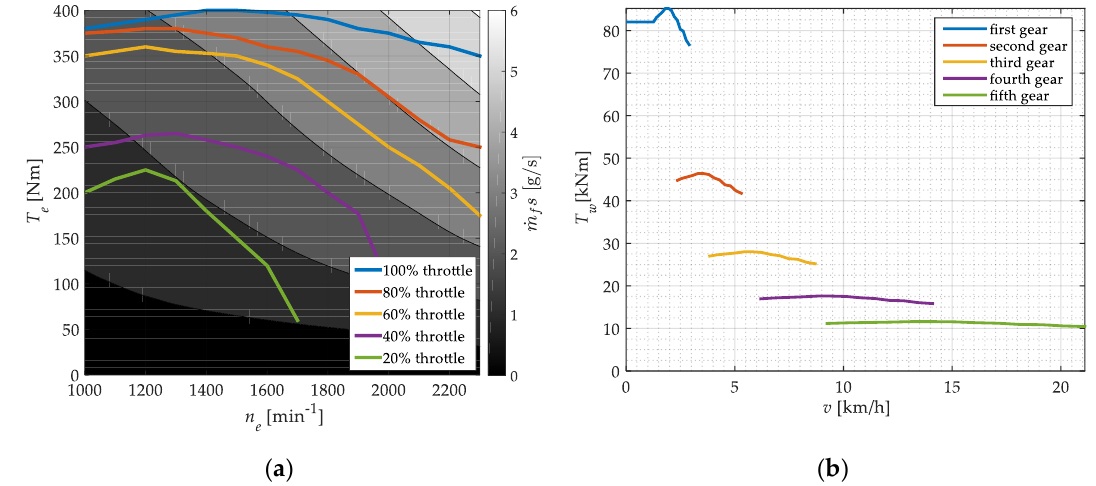
Figure 1. Fuel consumption map and torque curves dependent on throttle position ( a ), and output torque for selected gear and vehicle speed ( b ).